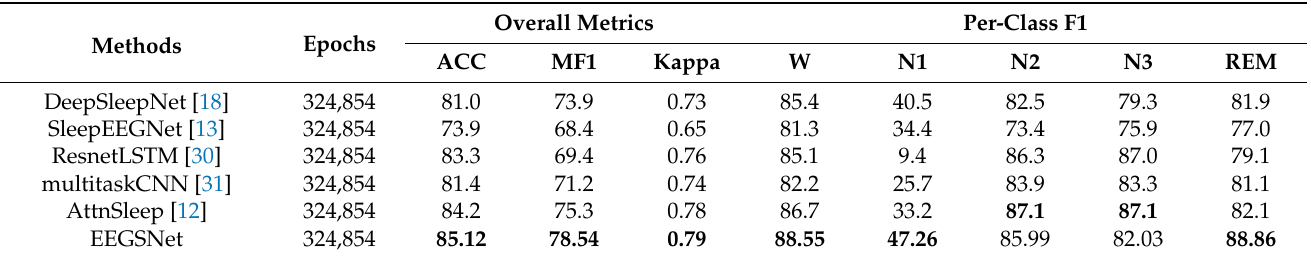
Table 10. Comparison of performance metrics obtained by our method with other state-of-the-art algorithms on